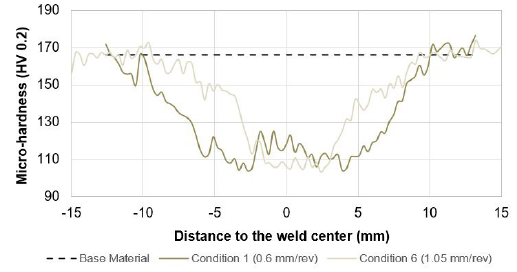
Figure 10. (a) Mid-thickness hardness profiles of the transversal cross-section surface of the joints produced with the highest (welding condition 1) and lowest (welding condition 6) energy inputs.